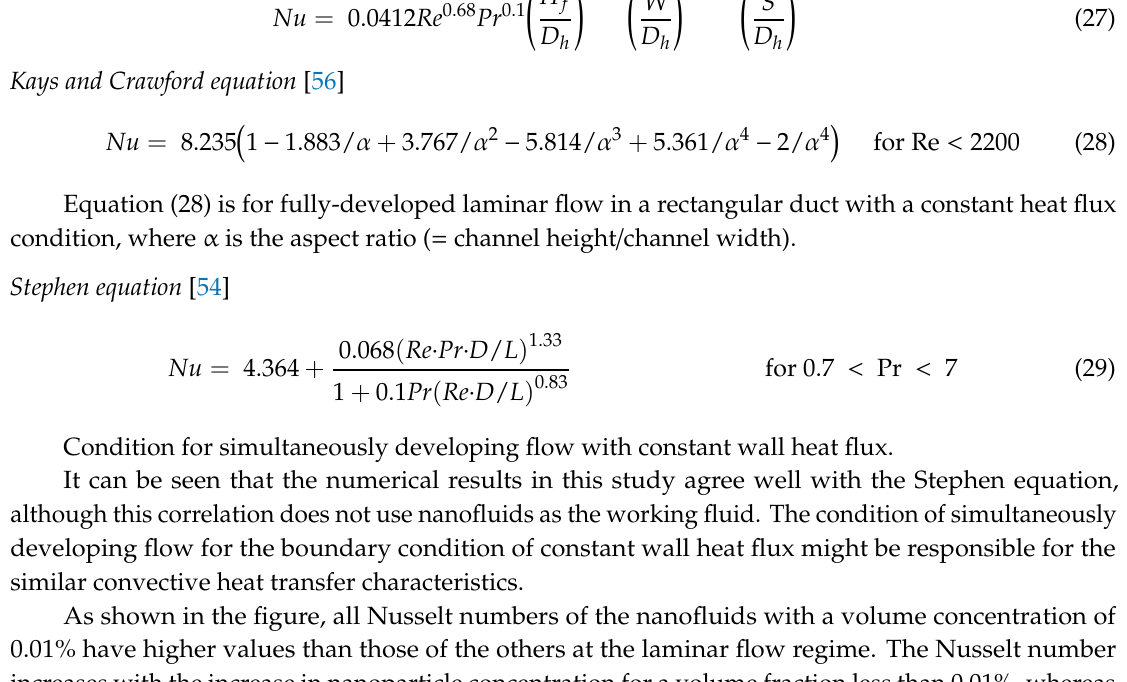
Figure 7. Comparison between the Nusselt number in the present study and the previous empirical results. Zhang equation